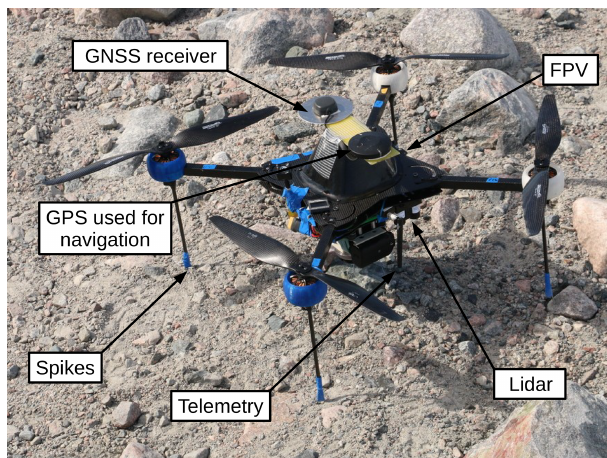
Figure 2. The Enduro quadcopter UAV that landed on Eqip Sermia